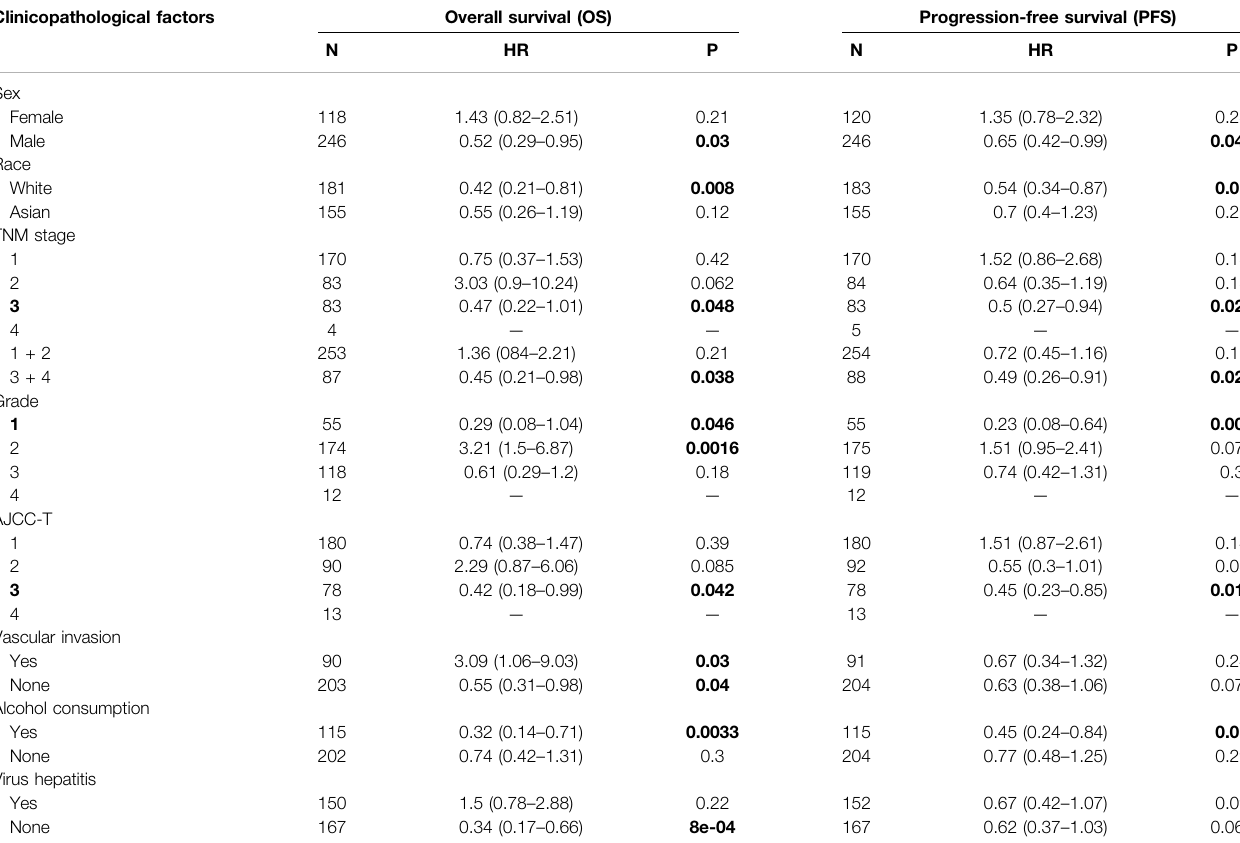
TABLE 2 | MT1H expression and prognosis in HCC with different clinicopathological factors. Clinicopathological factors Overall survival